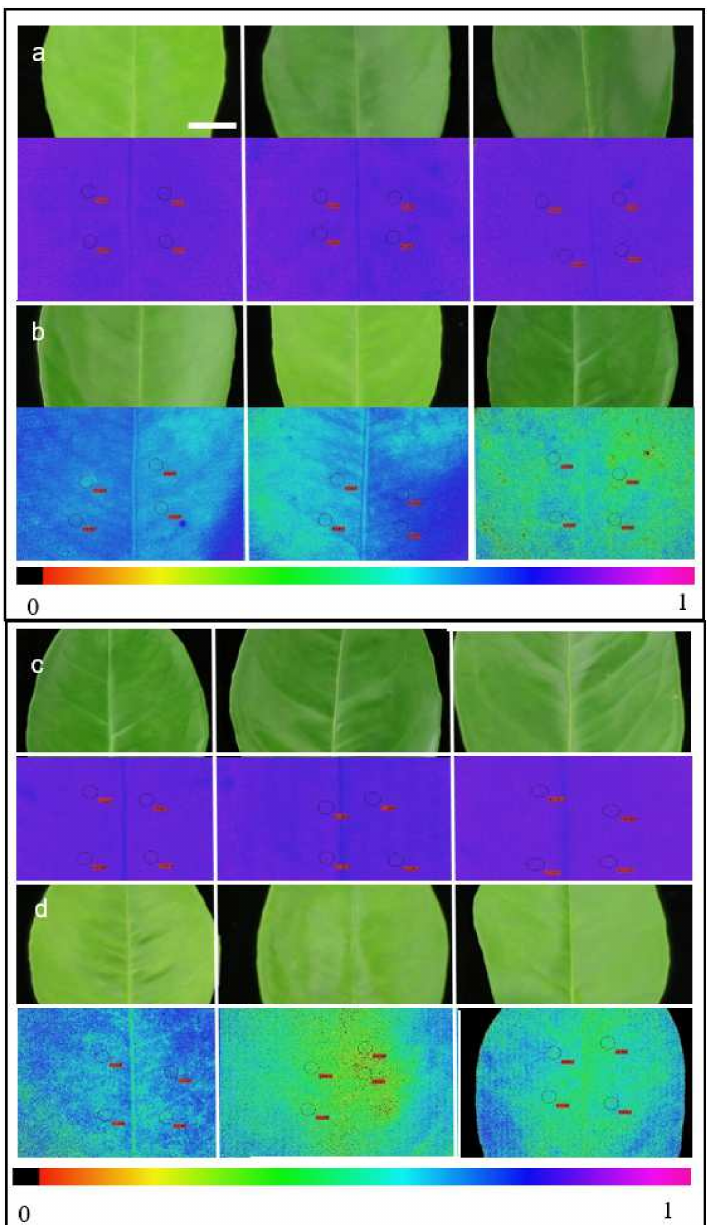
Figure 3. Representation of CFI (chlorophyll fluorescence imaging technique) of cold symptoms in citrus leaves exposed for 30 days to 1 ◦ C. ( a , c ) are the control groups of Carrizo citrange rootstock and Citrus macrophylla rootstock, respectively, grafted with the Valencia delta seedless variety. ( b , d ) where the cold treatment group of the Carrizo citrange rootstock and the Citrus macrophylla rootstock, respectively, grafted with the Valencia delta seedless